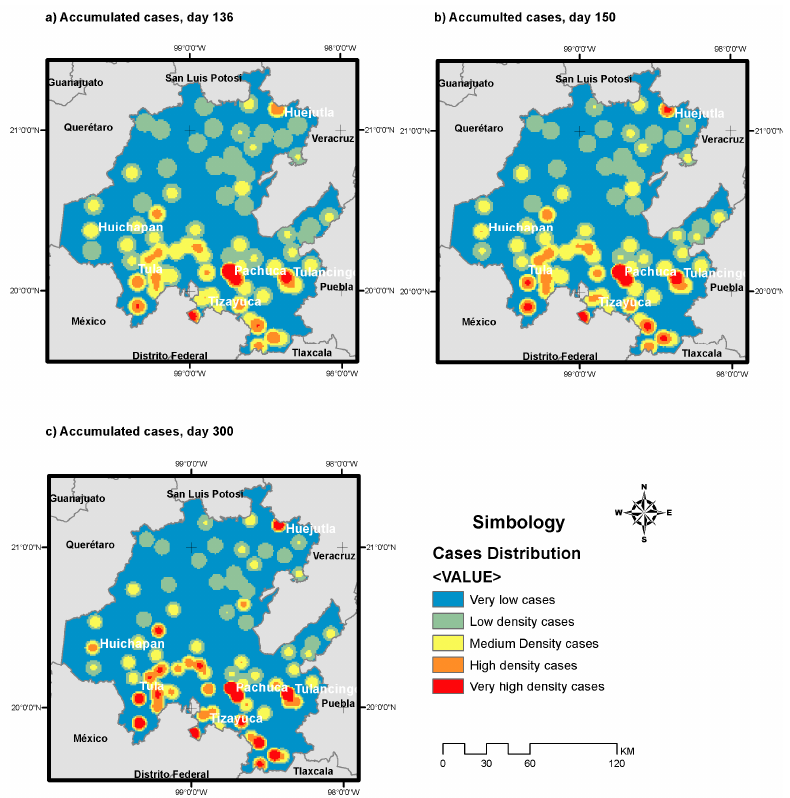
Figure 5. Case distribution based on population and workplaces density, based on kernel. ( a ) Accumulated cases at day 136. ( b ) Accumulated cases at day 150. ( c ) Accumulated cases at day 300.